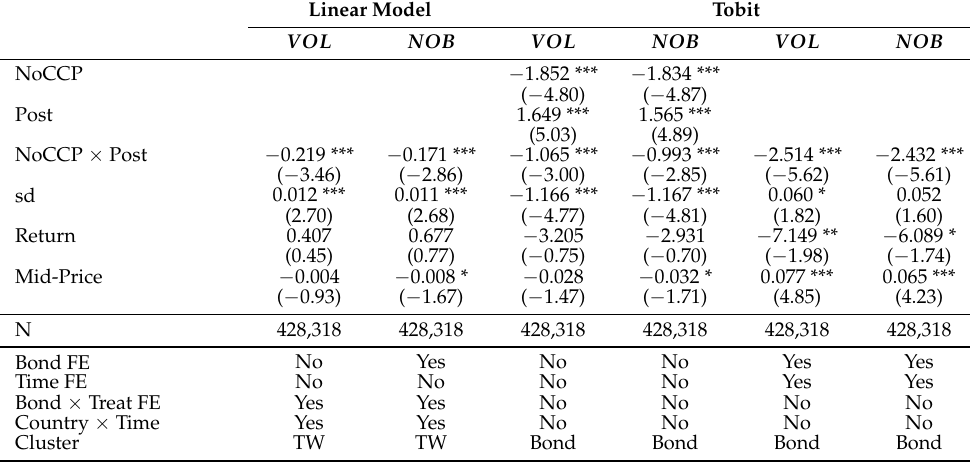
Table 10. Inclusion of zero-trading